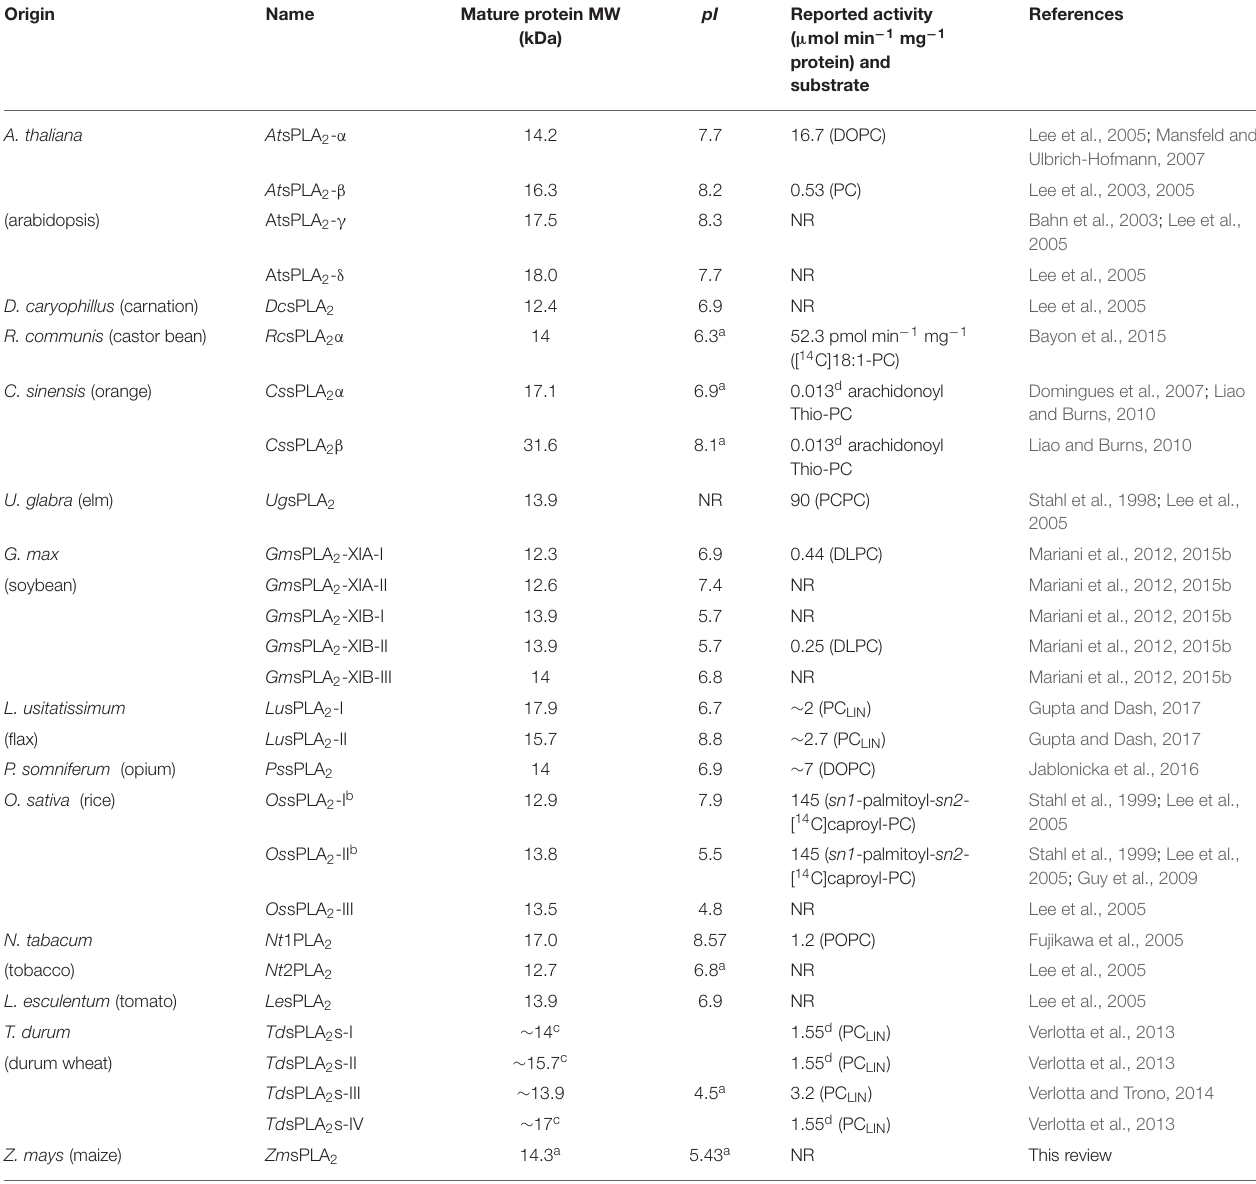
TABLE 4 | Molecular weight, isoelectric point, and specific activity of different sPLA 2 s from